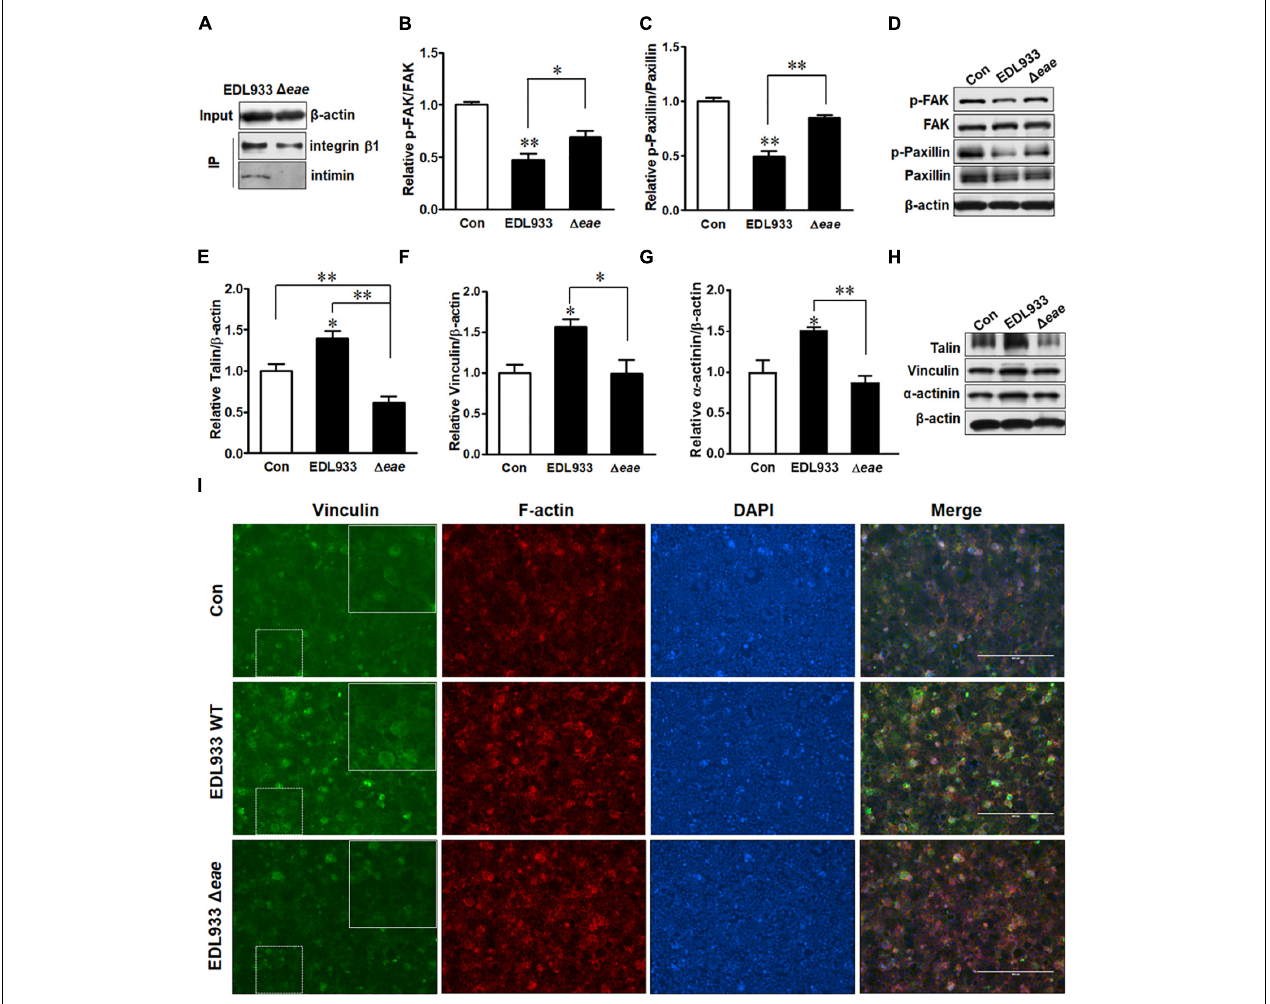
FIGURE 6 | Intimin was associated with focal adhesion alterations. (A) Co-immunoprecipitation of integrin β 1 and intimin interaction. Input, the whole cell lysate detected with β -actin antibody; IP, the immunoprecipitated lysates were immunoblotted with integrin β 1 or intimin antibodies. (B–D) Phosphorylation of FAK and paxillin. (E–H) Immunoblotting analysis of talin, vinculin, and α -actinin. (I) Immunofluorescence staining for vinculin in Caco-2 cells at 4 h post-infection with EDL933 strain or EDL933 intimin mutant strain ( (cid:49) eae ). Con, cells without infection; EDL933, cells infected with EDL933 strain; (cid:49) eae , cells infected with EDL933 intimin mutant strain. Blue, DAPI; Green, vinculin. Images were taken at 100 × magnification. Means ± SEM; n = 4. ∗∗ P ≤ 0.01; ∗ P ≤ 0.05.